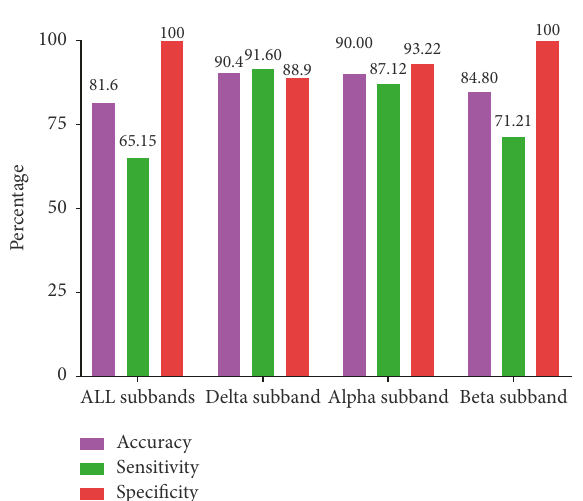
Figure 7: Performance parameters of SVM classifier based on dif- ferentsubbandenergiesofEEG.Accuracy,sensitivity,andspecificity are colour coded in the bar